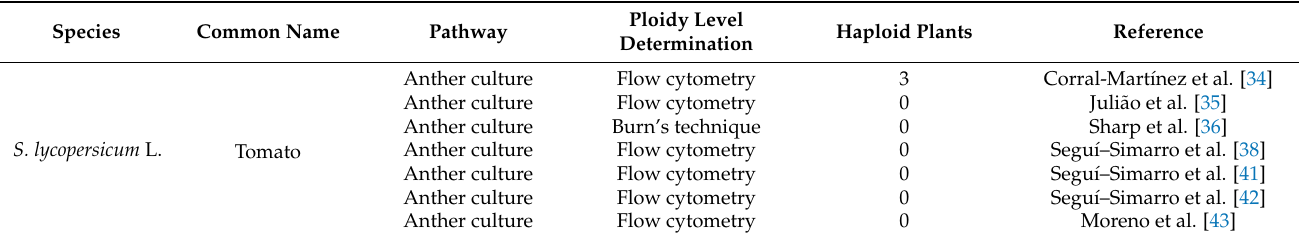
Table 1. Reports of androgenesis methodology in Solanum lycopersicum L.